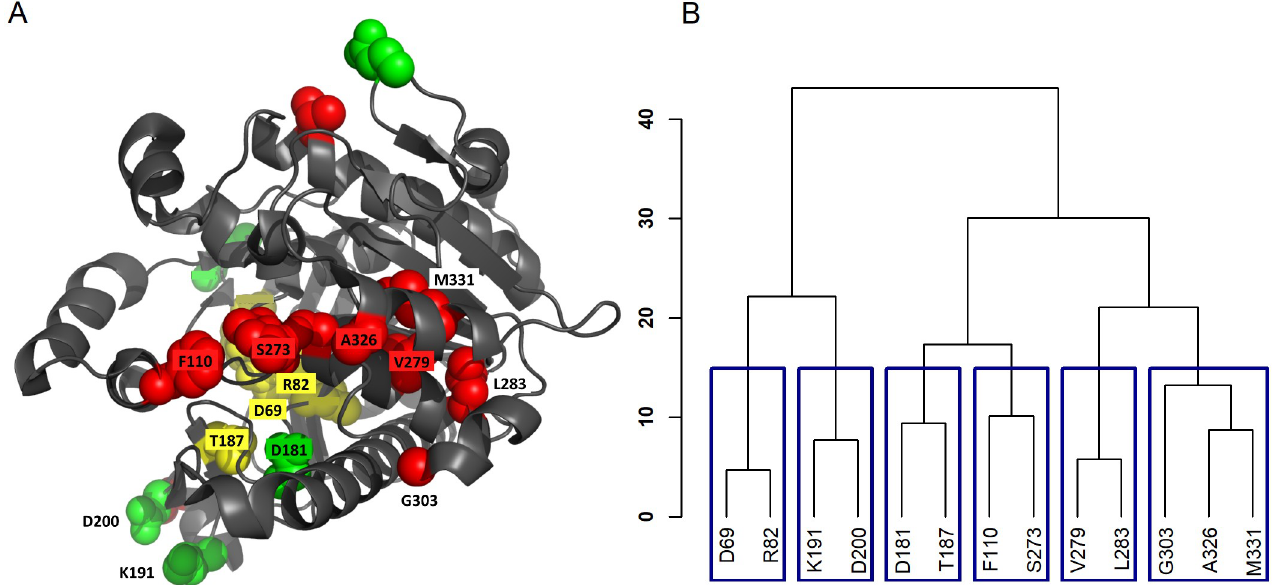
Fig 2. PLA2G7 rare variant positions. A: Rare variant locations on the protein tertiary structure. B: Corresponding Euclidean distance-based clustering of the variants.